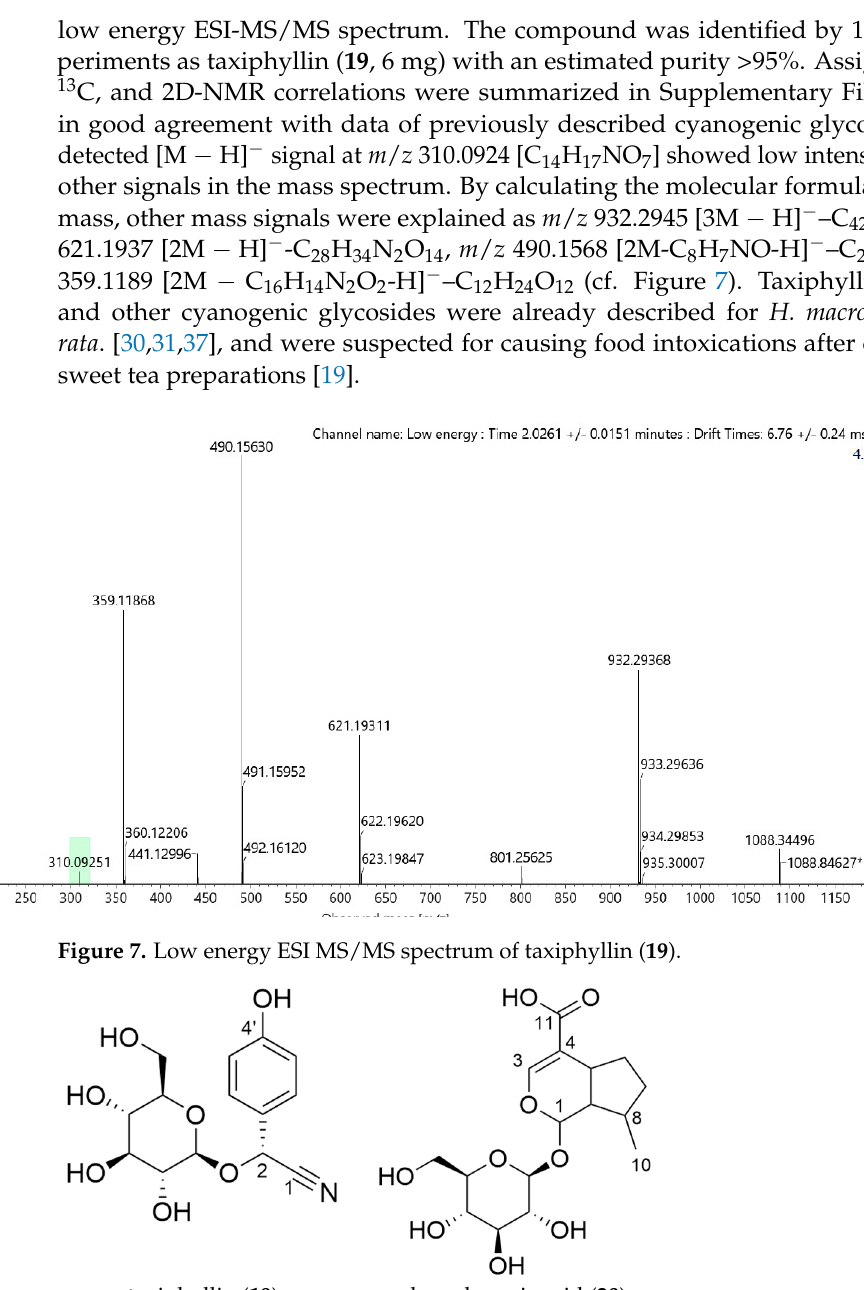
Figure 8. Molecular structures of taxiphyllin and deoxyloganic acid isolated from Hydrangea macrophylla ssp. serrata . phylla ssp. serrata